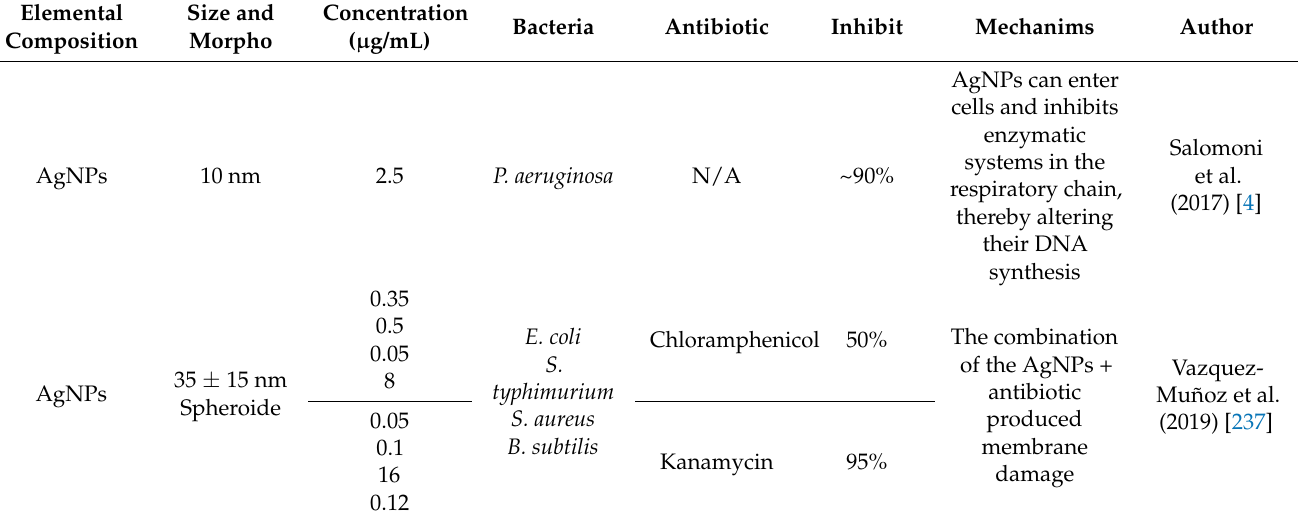
Table 2. Recent studies on metallic nanoparticles against pathogenic bacteria